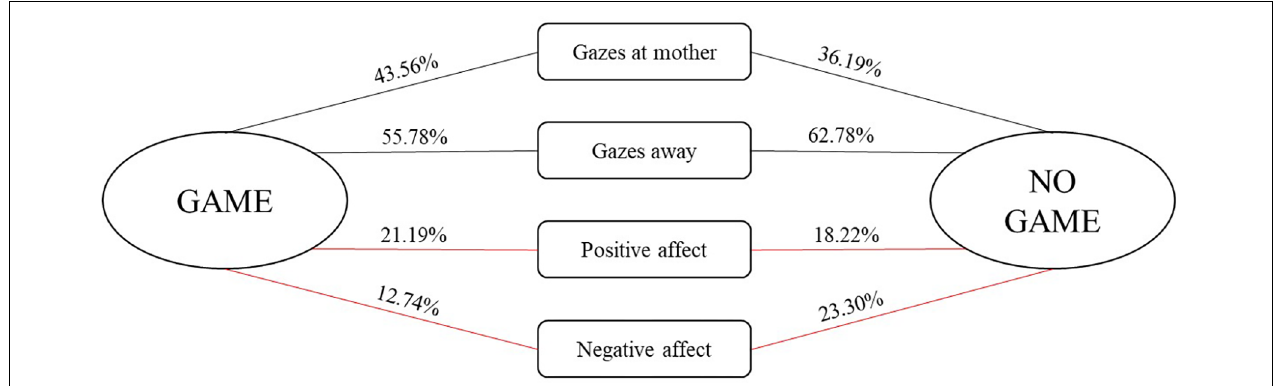
FIGURE 2 | Conditional probabilities (expressed in %) for the occurrence of infant social behaviors depending on whether they were followed by a game routine or another form of social interaction. Red lines indicate (marginally) significant pairwise comparisons between conditional probabilities for the occurrence of a particular behavior being followed by a game and another form of social